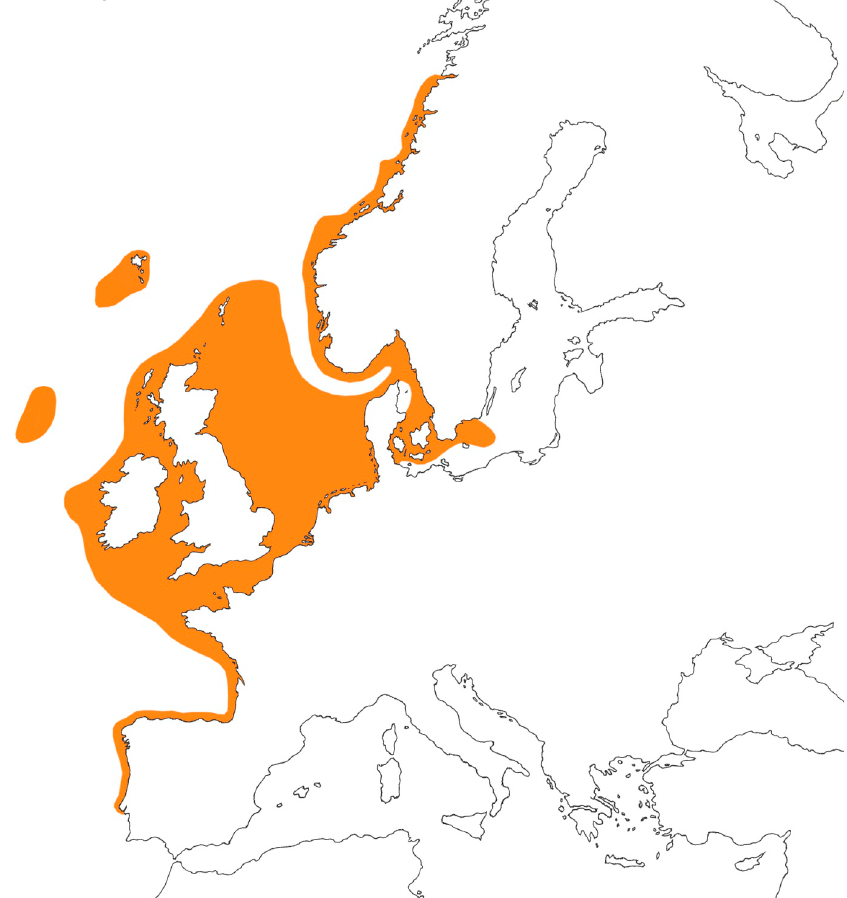
Figure 13. Present geographic distribution of Allotrisopterus minutus .